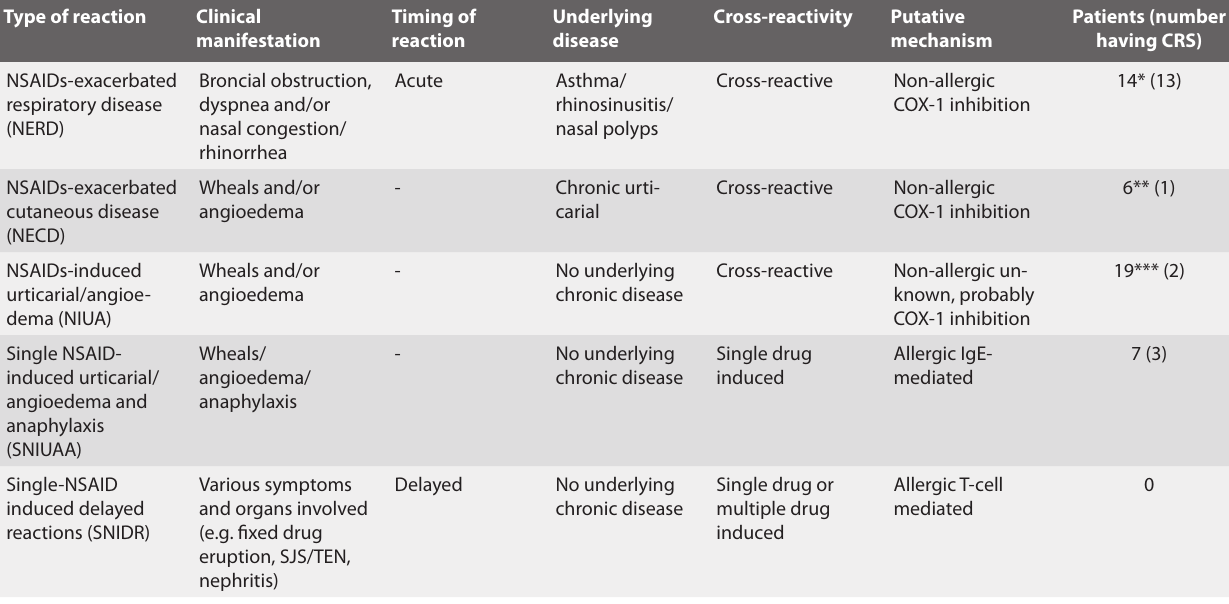
Table 1. Characteristics of 46 patients with NSAID hypersensitivity according to the EAACI/ENDA